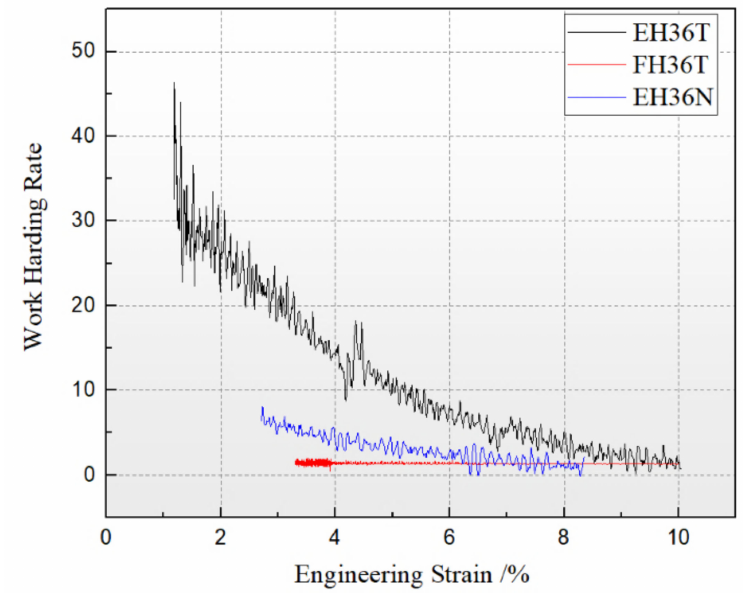
Figure 10. Work hardening rates of the offshore structural